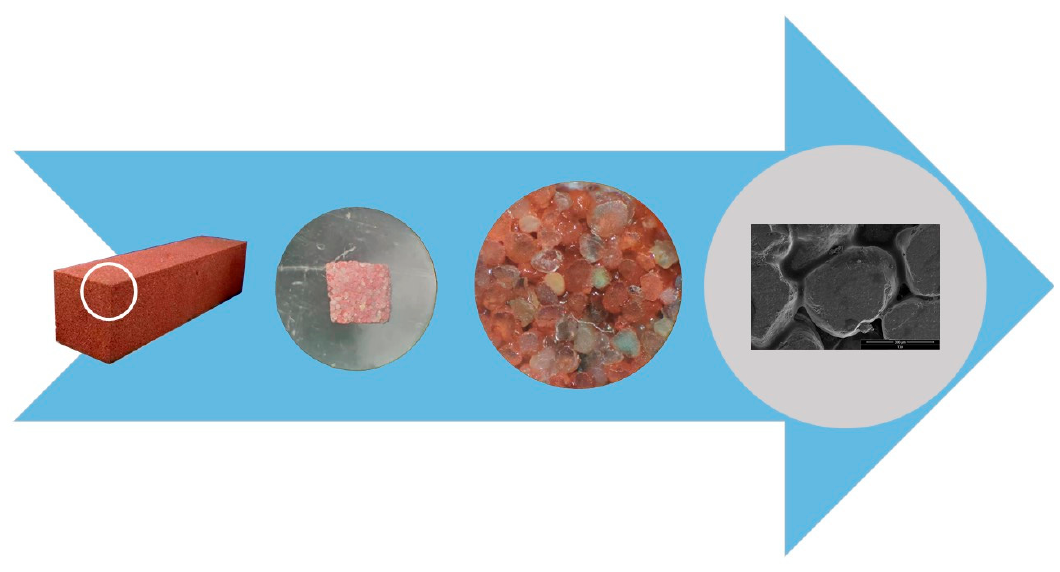
Figure 6. Sample preparation, grinding and image acquisition process.